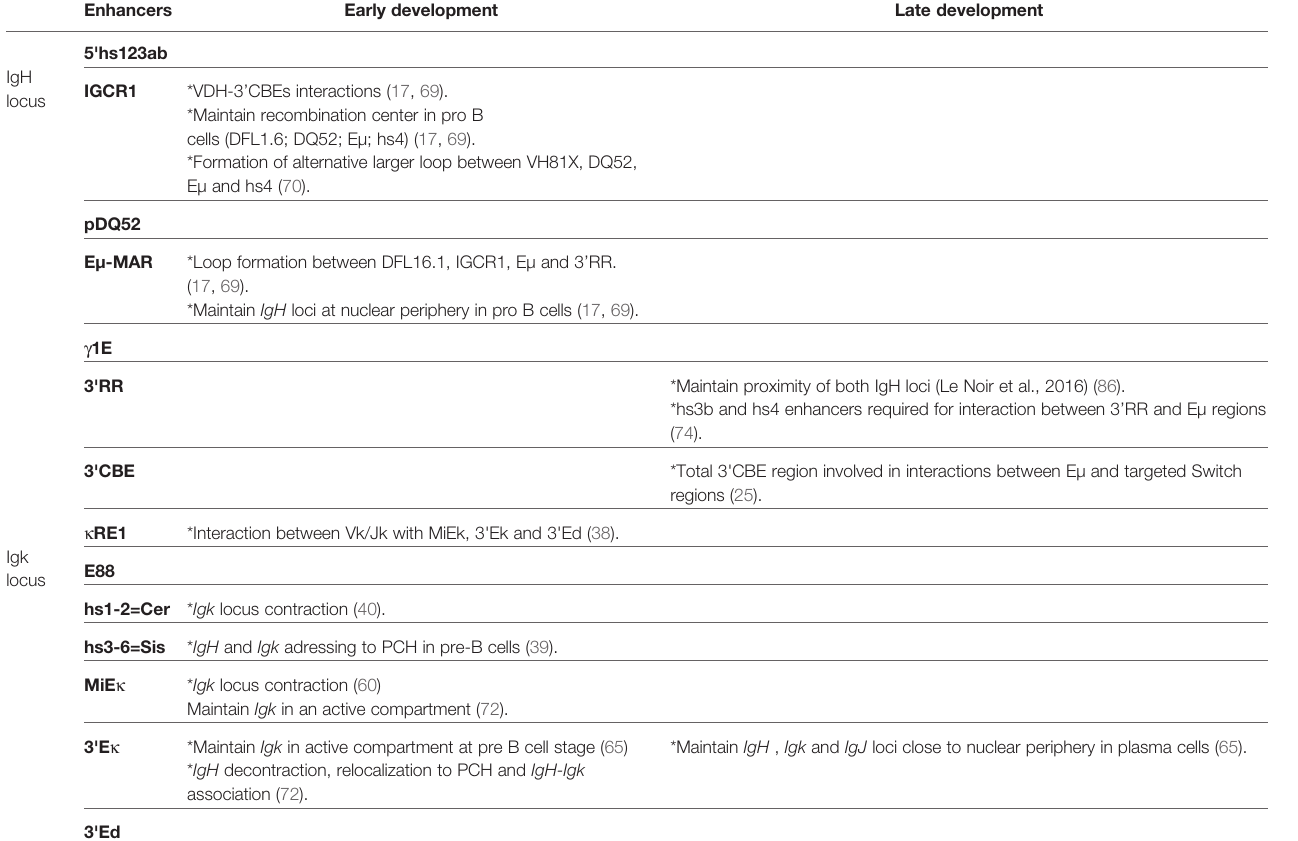
TABLE 1 | Contribution of Immunoglobulin enhancers to B Cell Nuclear Organization.